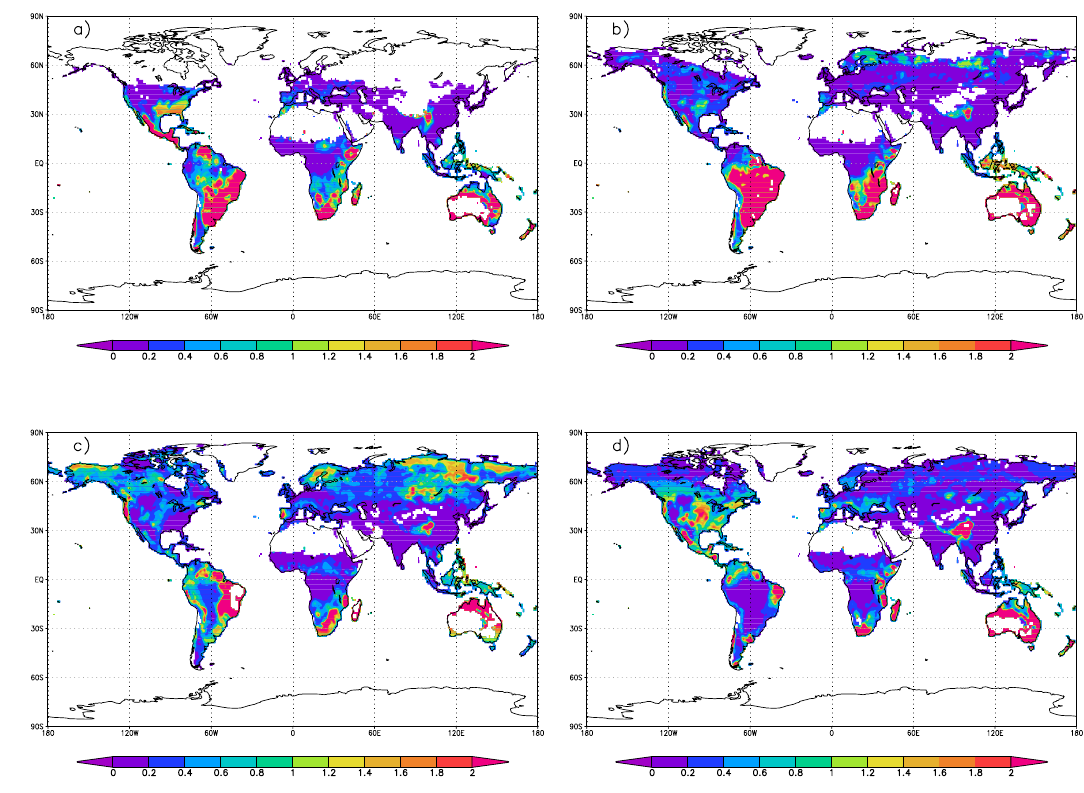
Fig. 4. The global distribution of the proxy given by Eq. (9), after replacing CS with AOD and assuming SO 2 concentration to be constant, for the different seasons of the year 2006: DJF (a) , MAM (b) , JJA (c) , and SON (d) . The unit of UV is mWm − 2 nm − 1 , AOD is unitless. Moreover, UV/AOD 2 is normalized by a factor of 10000 and the color scale is restricted to between 0 and 2, in order to better show the geographical patterns.